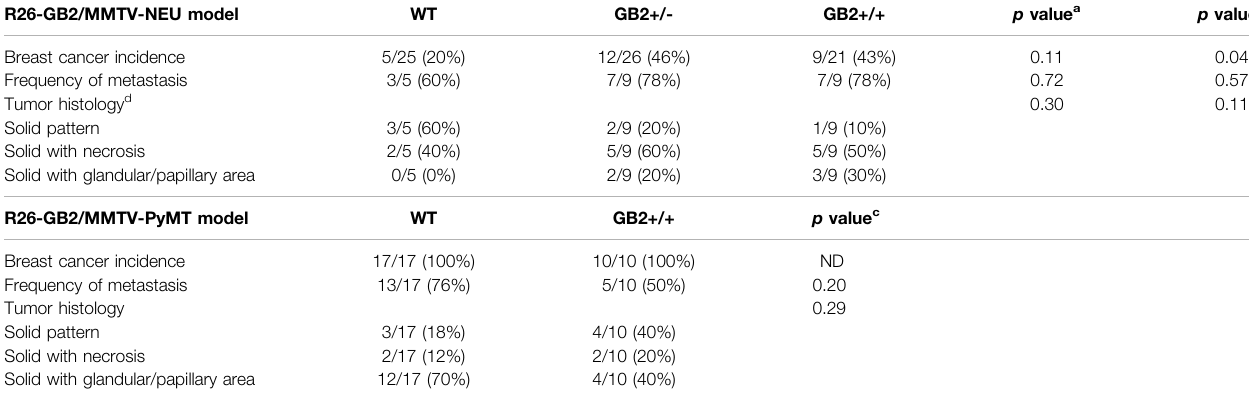
TABLE 2 | Cancer incidence, histology, and frequency of metastasis in the R26-GB2/MMTV-NEU and R26-GB2/MMTV-PyMT models. R26-GB2/MMTV-NEU model WT Breast cancer